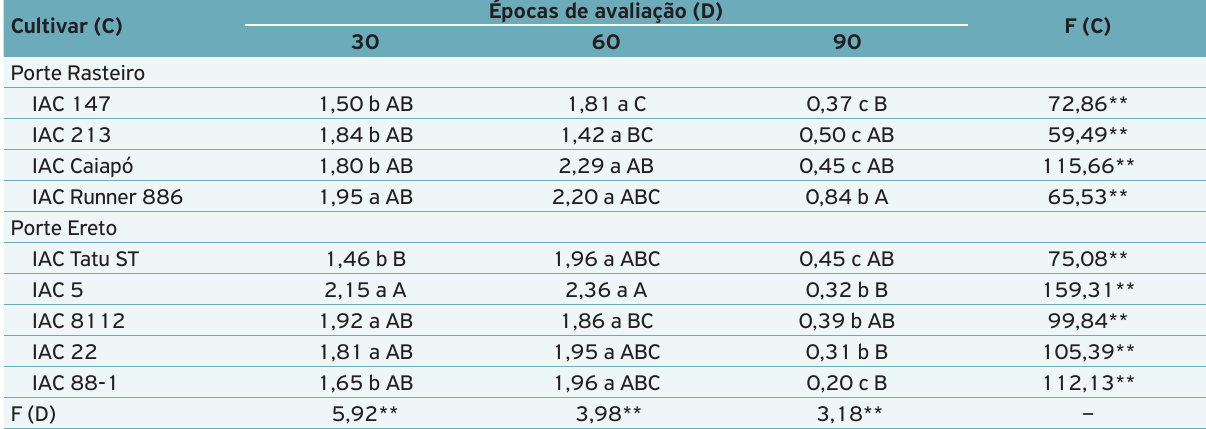
Tabela 5. Valores da análise de desdobramento da interação entre cultivares de amendoim versus épocas de avaliação, referentes ao número médio de brotos por planta, sob infestação natural de Stegasta bosquella em campo. Urutaí (GO), 2010/2011.